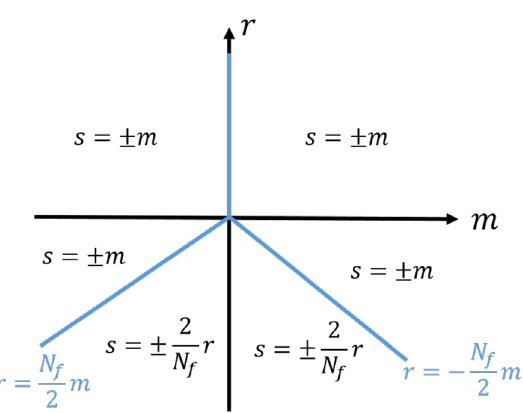
Figure 4 . Phase diagram of the U(1) 0 gauge theory with N f charge +1 matter (cid:12)elds (we draw the phase diagram at generic points and ignore some rays along which moduli spaces open up). The low-energy theories at s = (cid:6) 2 r are U(1) , while the low-energy theories at s = (cid:6) m are a (cid:7) N f = 2 N f CP N f = 2 (cid:0) 1 model. Along the blue lines, moduli spaces open up. As we go around the circle, we (cid:12)nd vacuum